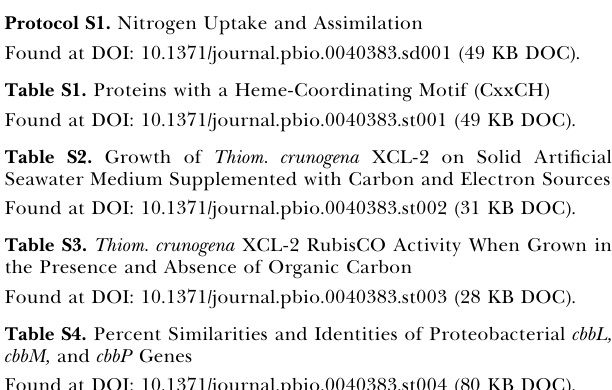
Table S5. Amino Acid Biosynthesis Gene Organization in Thiomi. crunogena XCL-2 versus E. coli Found at DOI: 10.1371/journal.pbio.0040383.st005 (29 KB DOC). Table S6. Thiom. crunogena XCL-2 Regulatory and Signaling